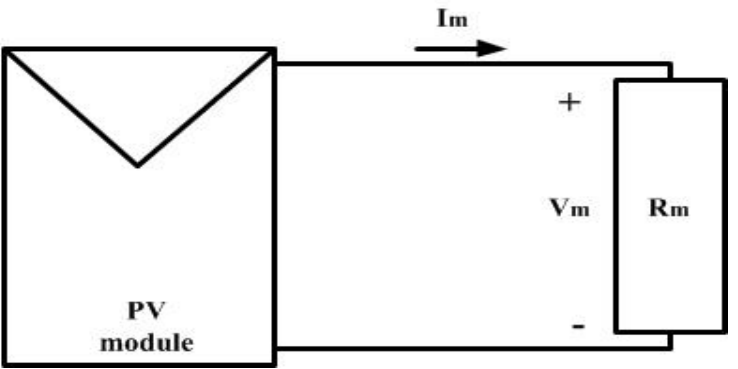
Figure 3. Impedance matching for maximum power transfer.